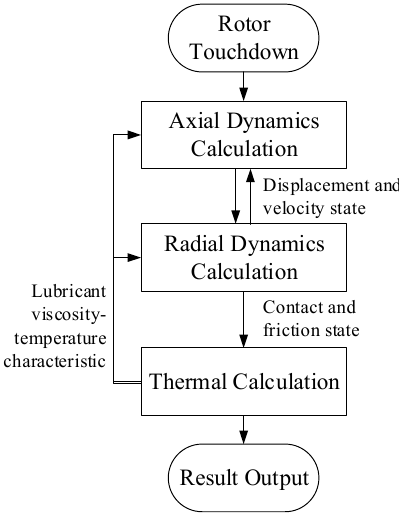
Figure 5. Contact model of the rotor and TDB inner ring.